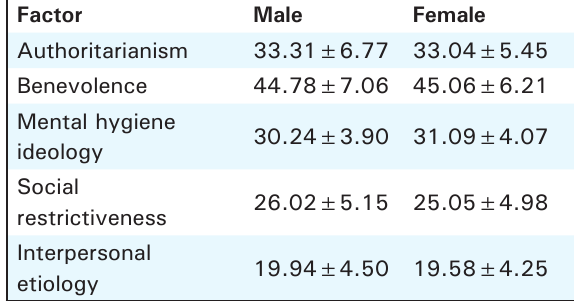
Table 2. OMI score (Mean ± Standard deviation) in medical students and interns by